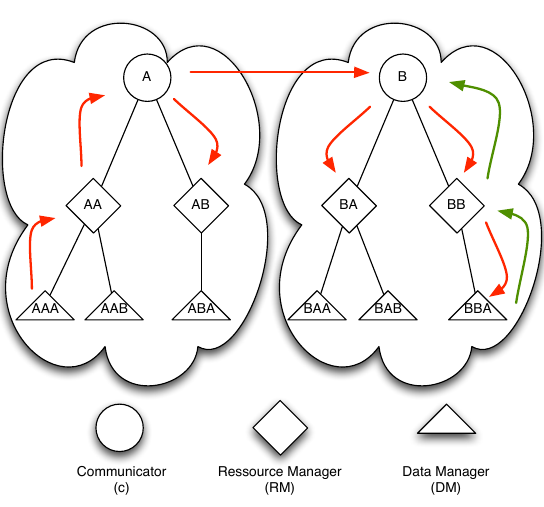
Figure 4. Resource lookup in a routing